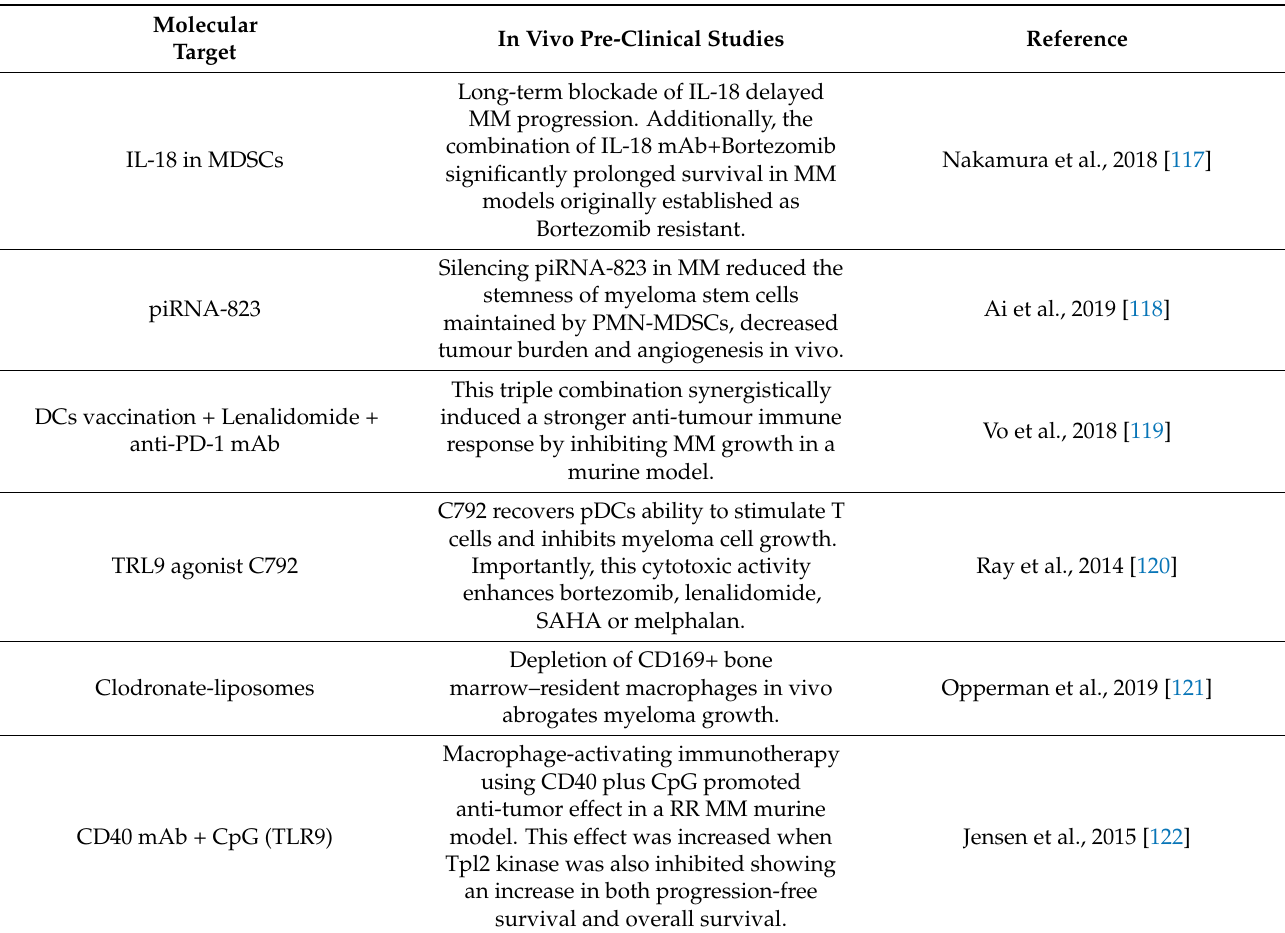
Table 1. In vivo pre-clinical tests showing promising molecules against multiple myeloma (MM) bone marrow (BM) milieu to overcome